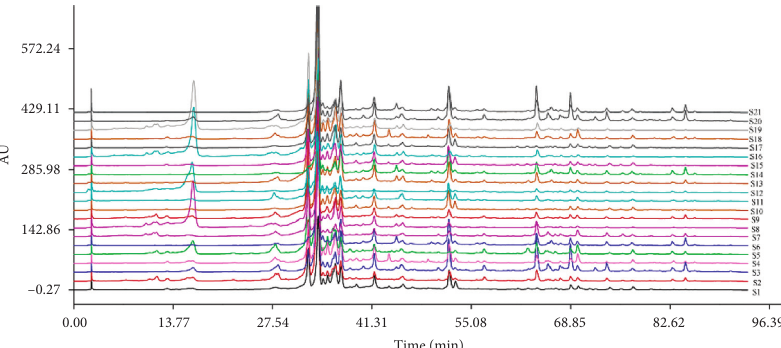
Figure 2: HPLC fingerprint of total flavonoids of Glycyrrhiza uralensis Fisch. from 21 producing areas.